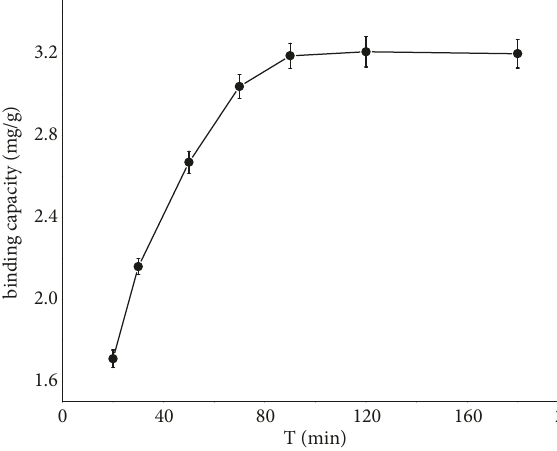
Figure 7: Dynamic adsorptions of